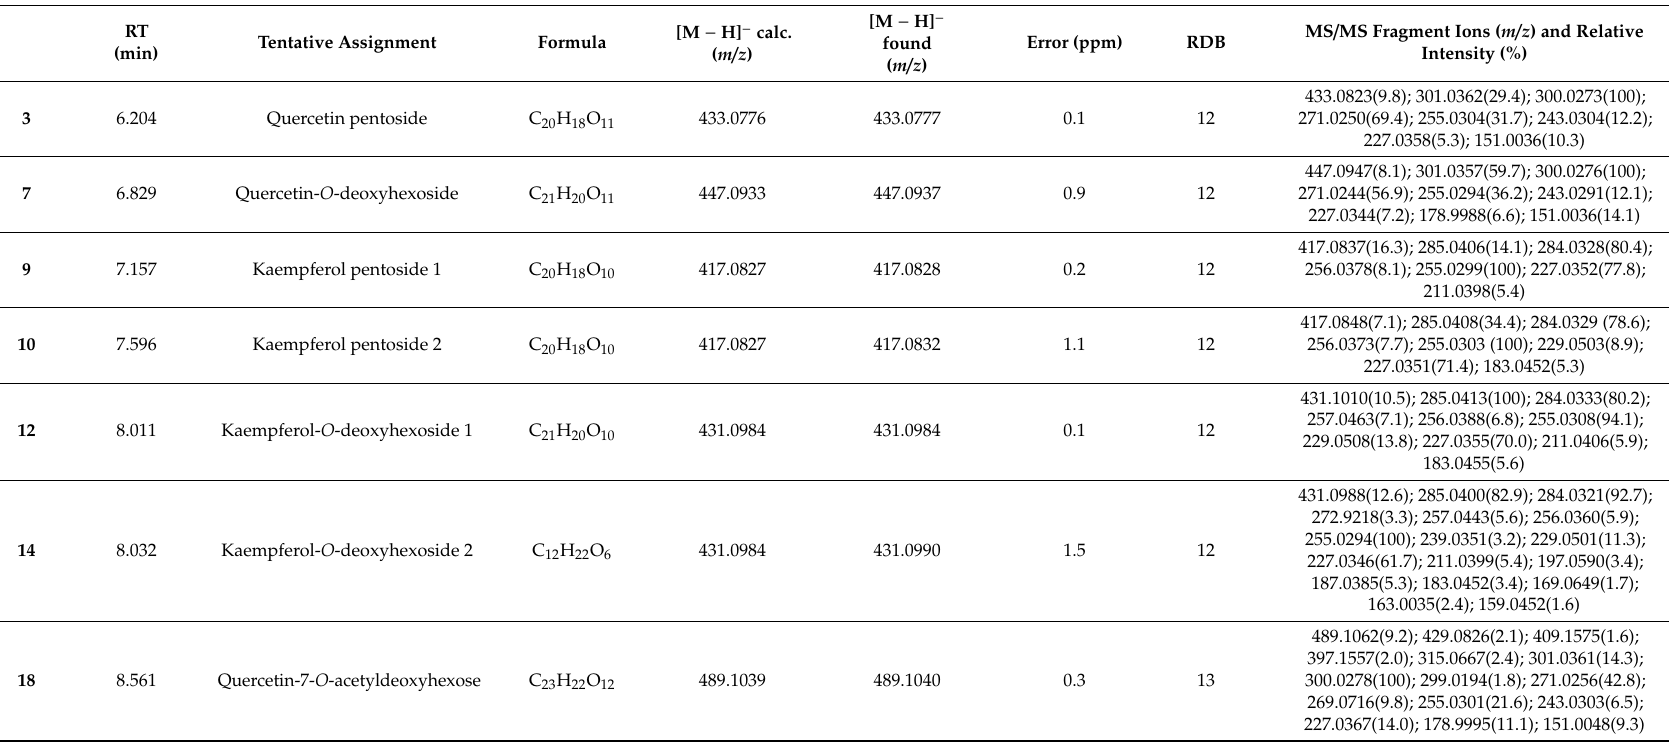
Table 3. TOF-MS and TOF-MS / MS of tentatively identified flavonol glycosides in the investigated hempseed fraction. RT = Retention Time; RDB = Ring Double Bond equivalent value. Compounds were numbered based on their RT in the whole LnHS